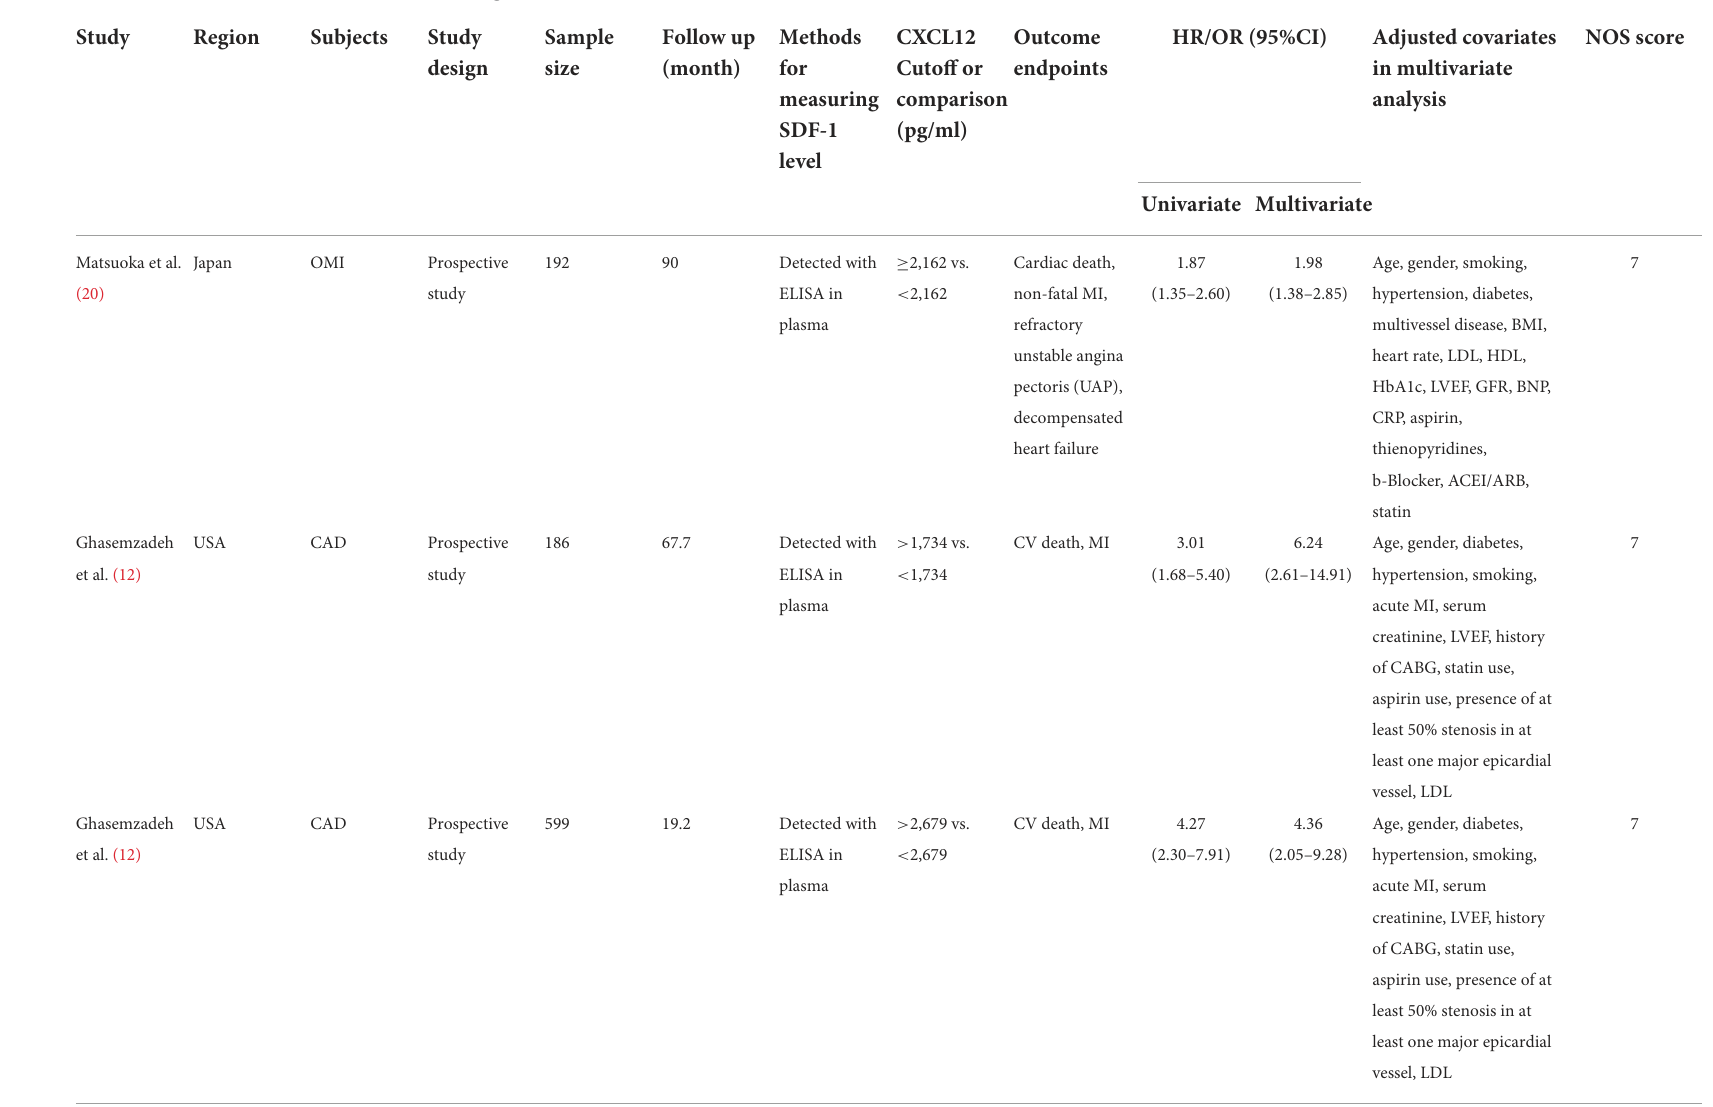
TABLE 1 Clinical characteristics of the included original